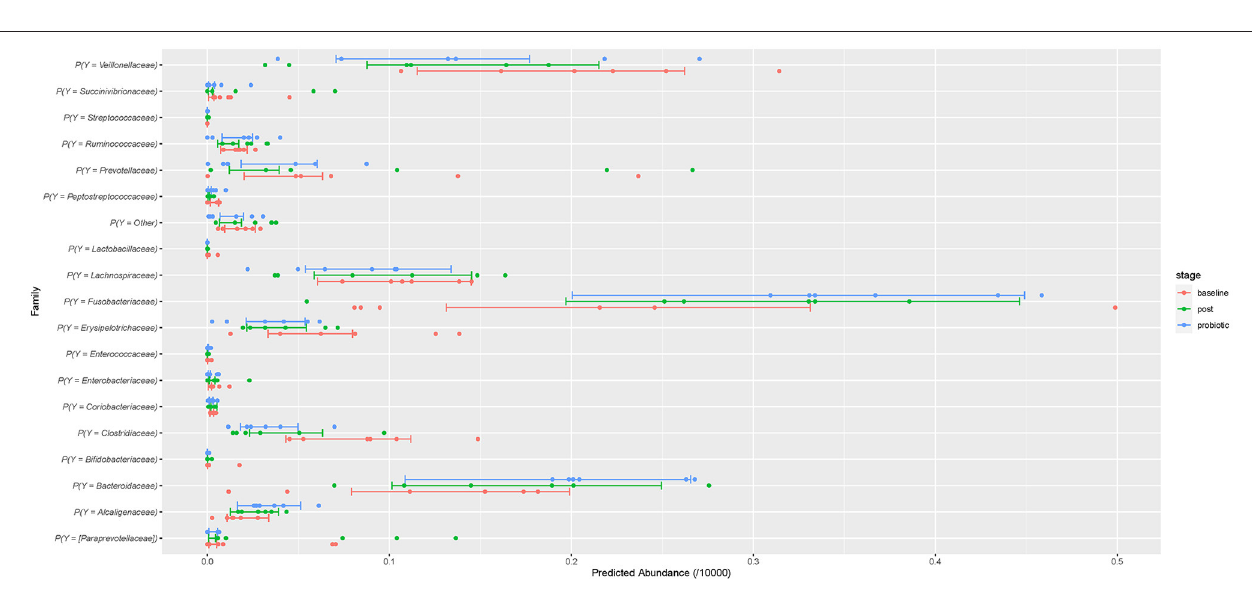
FIGURE 4 | The predicted relative abundances at family level assuming 10,000 multinomial trials. The points are the individual-level predictions. The bars are the 50% credible intervals for the population prediction. Red represents baseline abundance, blue during probiotic administration, and green after cessation of the